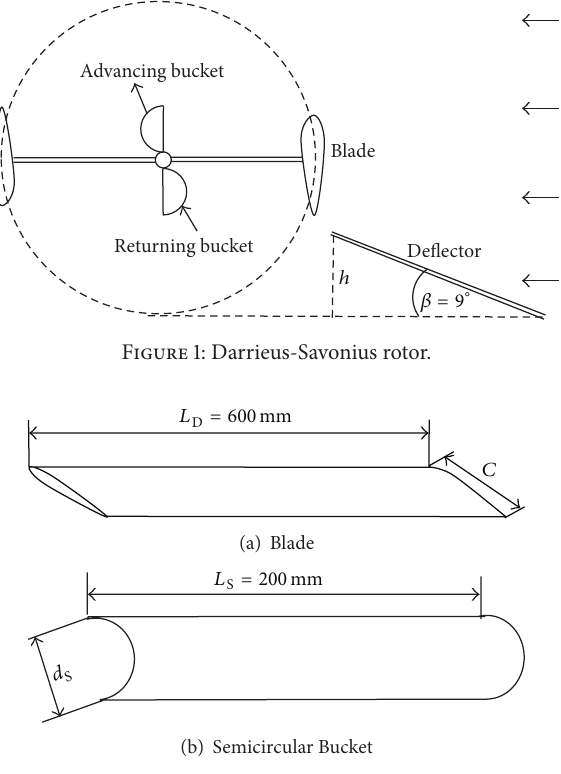
Figure 2: Geometrical blade and